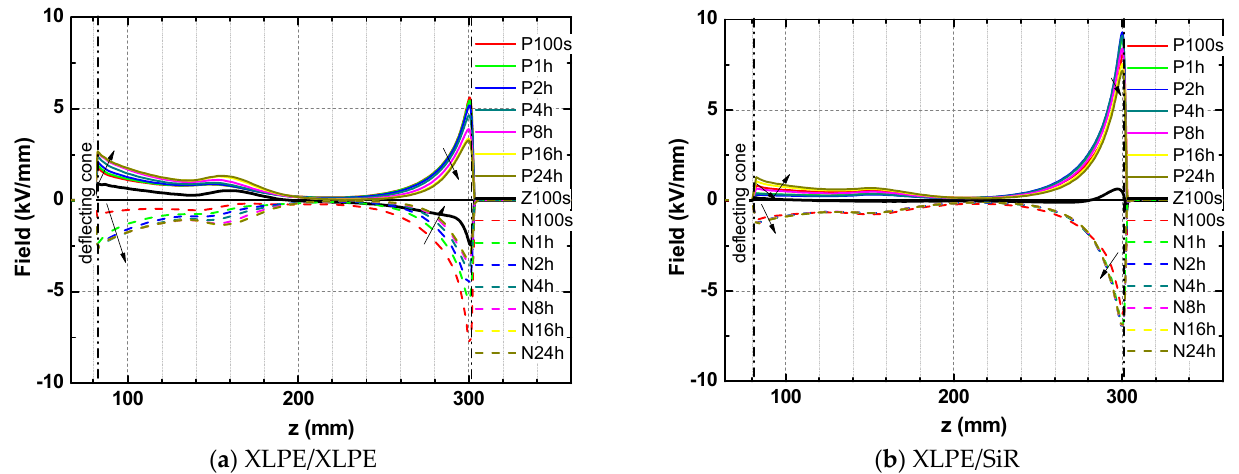
Figure 8a: the common feature here is a higher conductivity in the joint material than in XLPE.